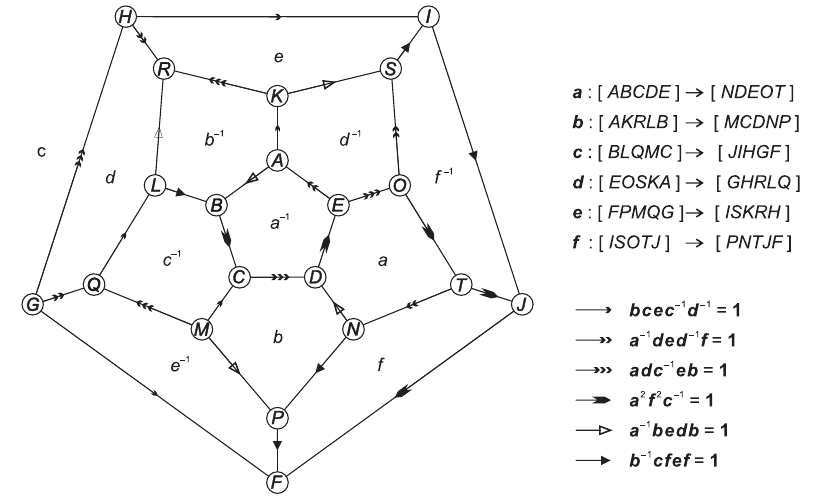
Figure 10. Face identification of the dodecahedron yielding compact hyperbolic manifold of first homology group Z 29